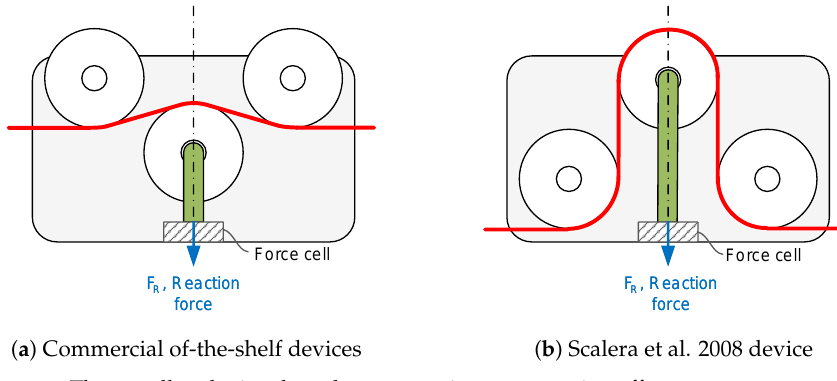
Figure 3. Three-pulley devices based on measuring compression